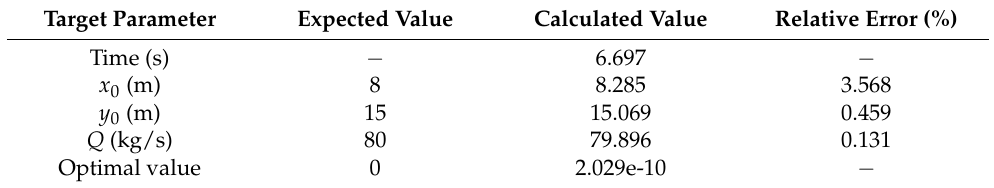
Table 11. Qualitative results table of OMO algorithm with a precision of 1e-10 under 16 sensors. Target Parameter